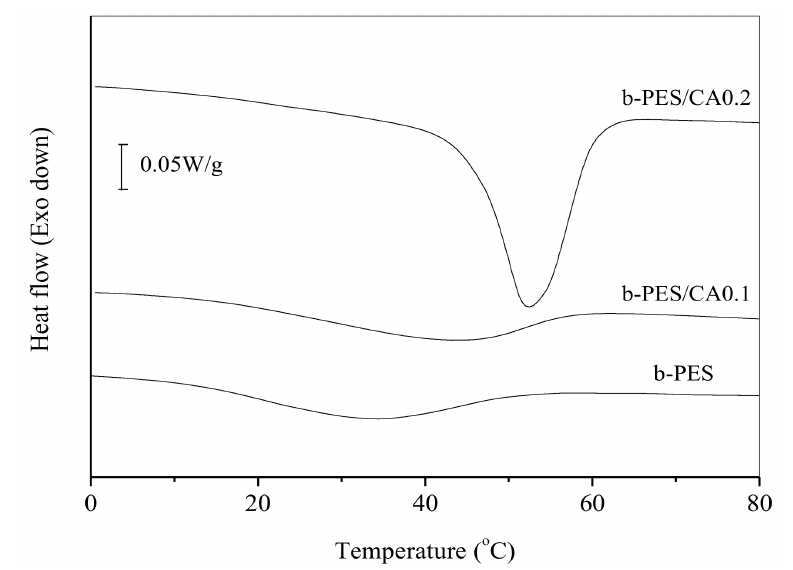
Figure 2. Nonisothermal melt crystallization behavior of neat and nucleated b-PES at a cooling rate of 5 ◦